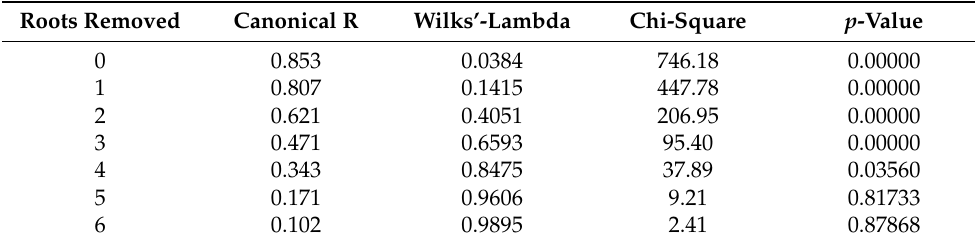
Table 2. Chi-Square tests with successive roots